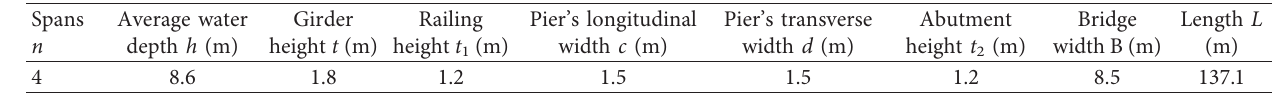
Figure 5: Profile of Shangban Bridge. Table 1: Parameters of Shangban Bridge.